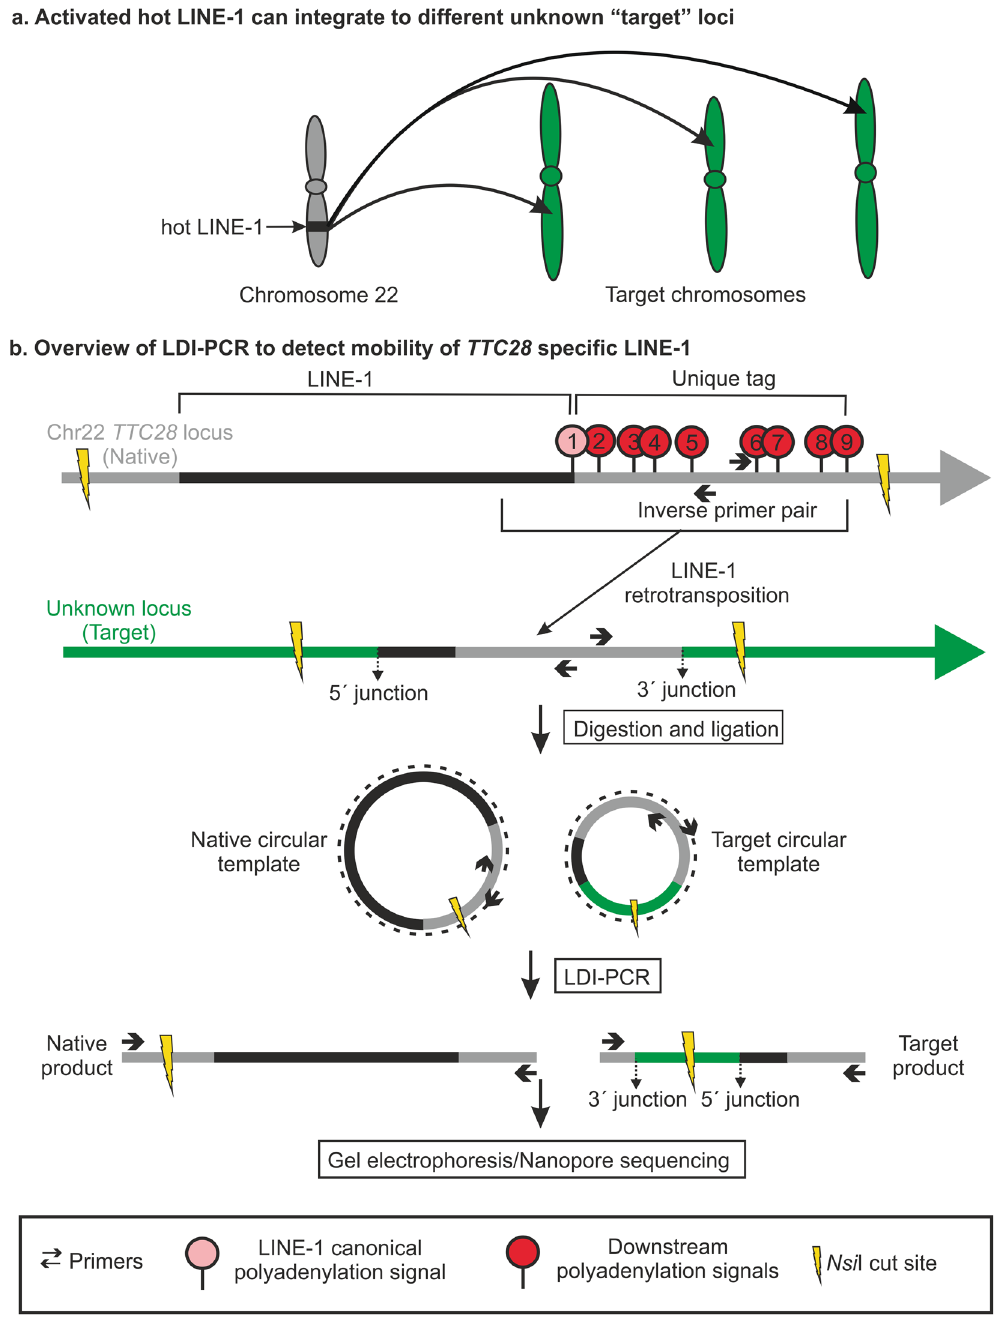
Figure 1. LDI-PCR based method to detect the activity of a hot L1. ( a ) Schematic showing mobility of hot L1 from the TTC28 locus upon activation. ( b ) LDI-PCR to detect 3 ′ transduction arising from the L1 at TTC28 : Schematic representation of a hypothetical TTC28 specific L1 retrotransposition including transduction of 3 ′ flanking region or the “unique tag” ( = region between the canonical polyadenylation signal and an alternative polyadenylation signal downstream), into an unknown target locus. Nsi I produces restriction fragments of two different sizes that are self-ligated to form a circular template. Upon LDI-PCR, an inverse primer pair directed at the unique tag produces a native product and an insertion-specific target product. In addition to Nsi I, two further restriction enzymes ( Pst I and Sac I) and primer pairs (not depicted here) were used; see Materials and Methods for